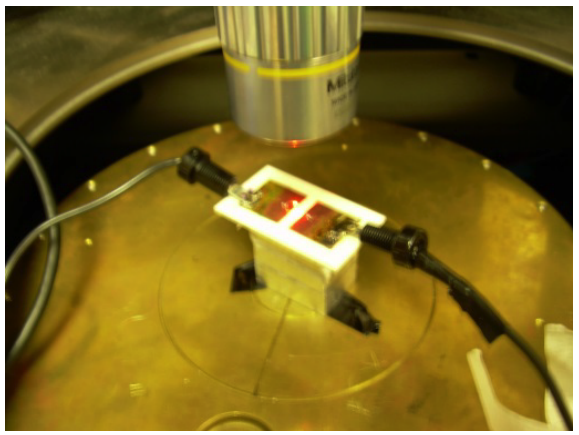
Figure 2. Measurement of wire displacement.